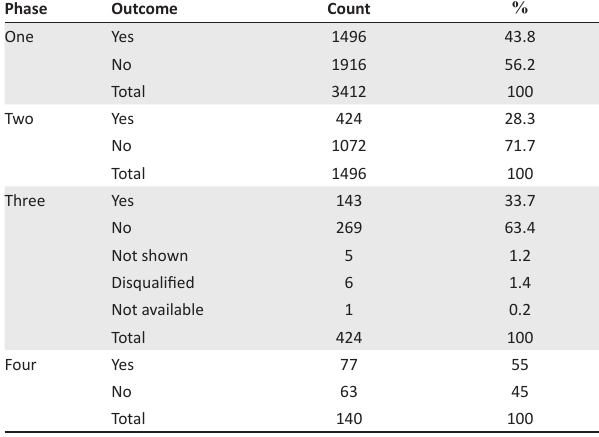
TABLE 5: Cross-tabulation of phase survival rate